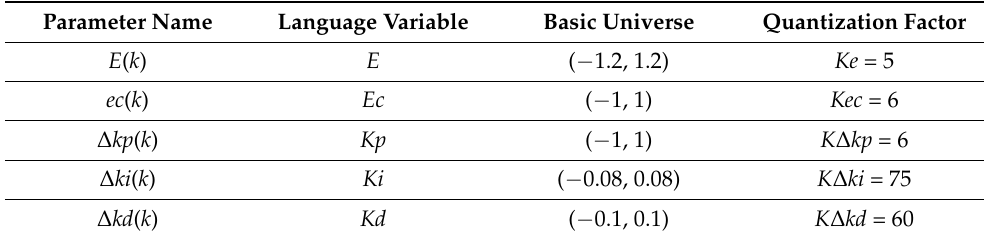
Table 1. Specific parameter settings of the fuzzy PID controller.